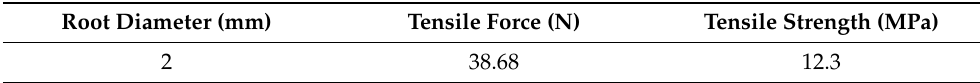
Table 4. Test results of root tensile strength of Chinese fir.